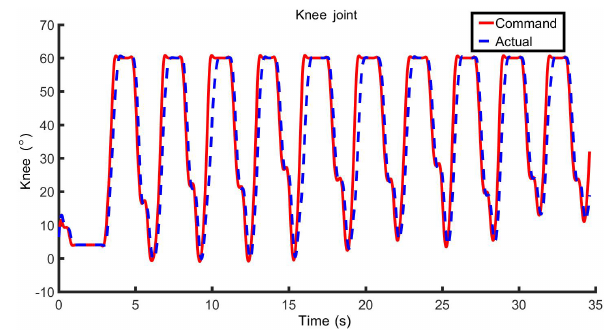
Figure 17. Trajectory tracking for the knee